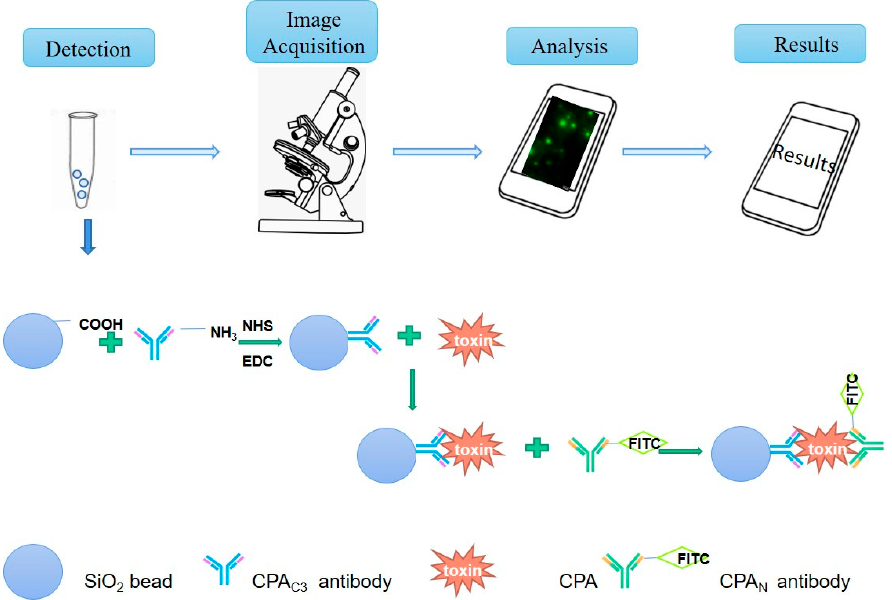
Figure1. Theprincipleofsilicamicrosphereconjugatedfluorescentantibodycombinedwithsmartphone app detection